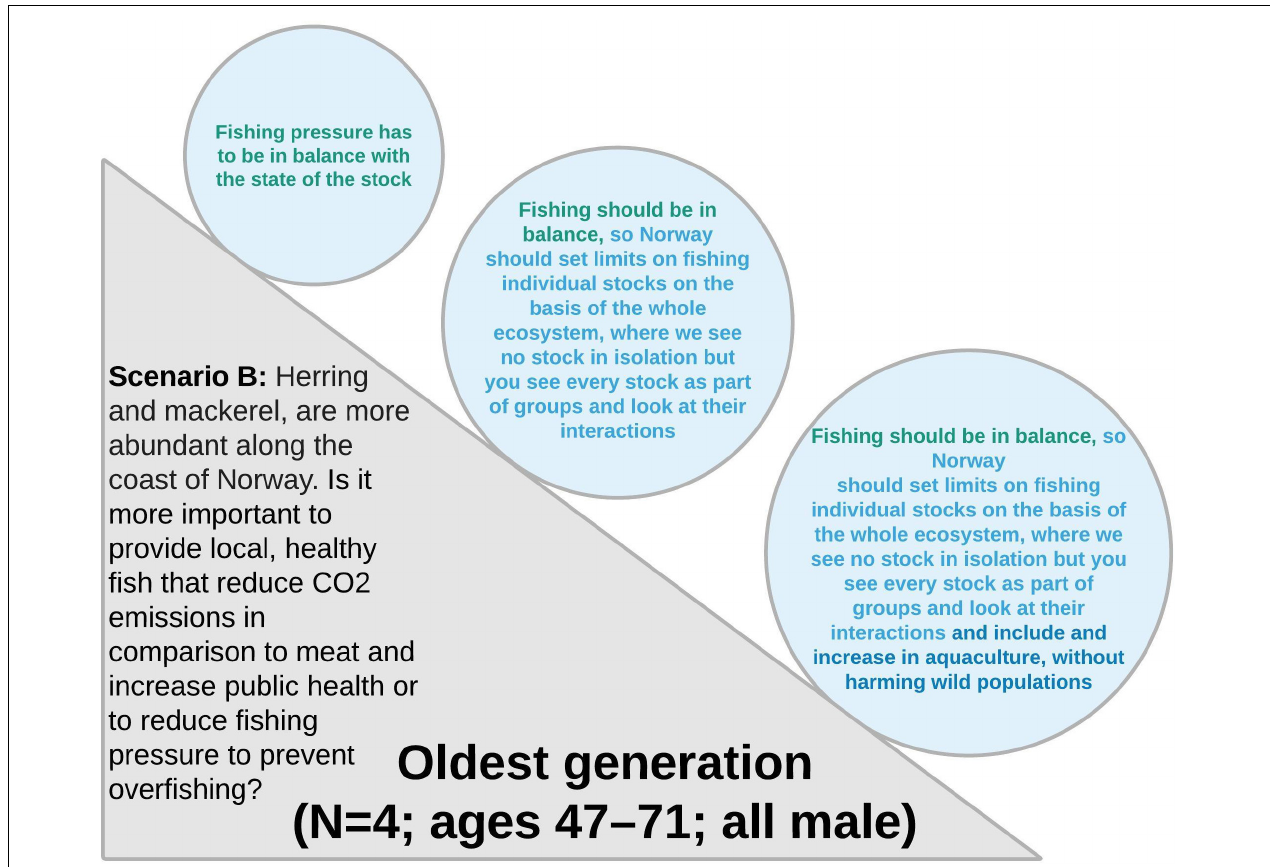
FIGURE 8 | A schematic summarizing the discussion among the group of the oldest participants in the workshop in Bergen, Norway, June